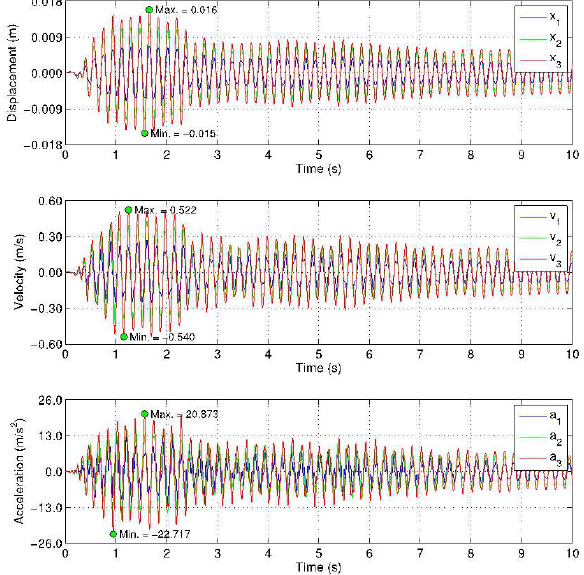
Figure 4: Uncontrolled response of the 3DOFs